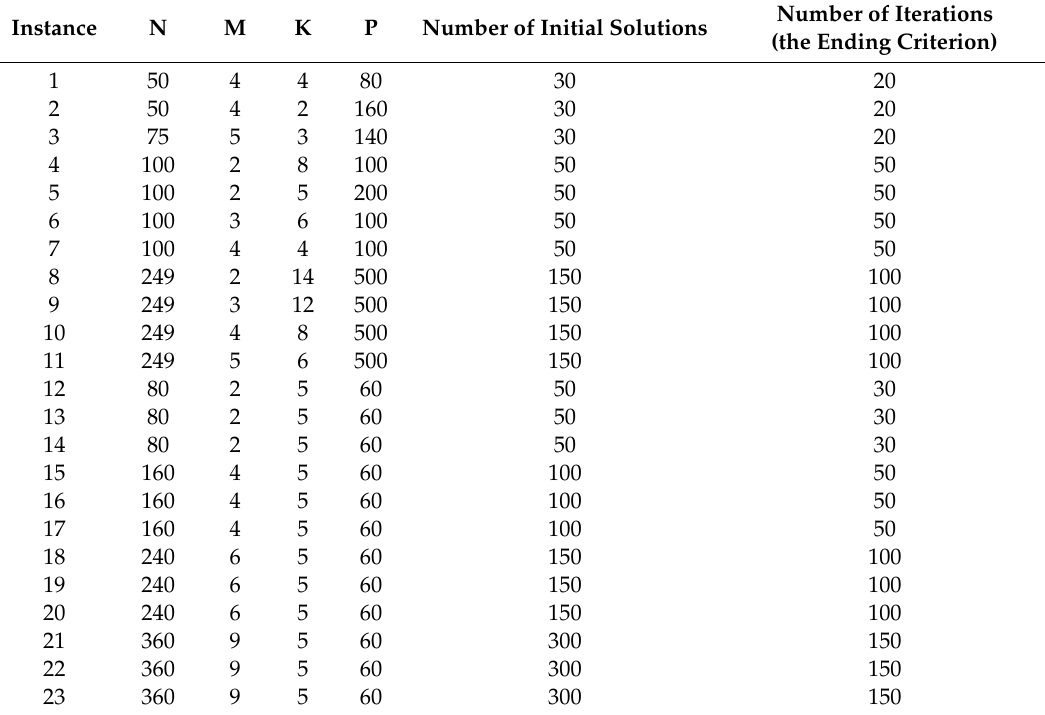
Table 2. The parameters for initialization on the benchmark